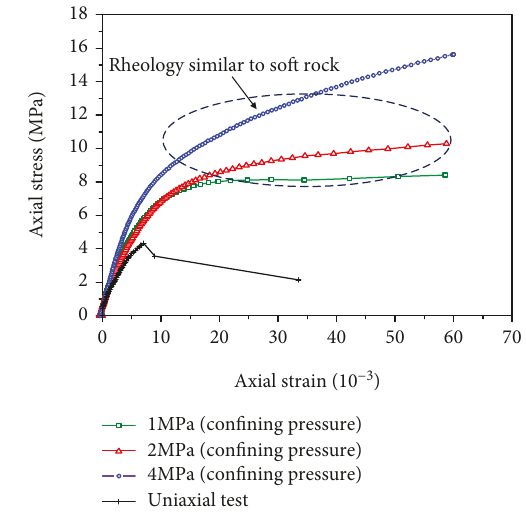
Figure 4: Stress-strain curves of triaxial and uniaxial compression tests for nonexpansive specimens ( m = 1